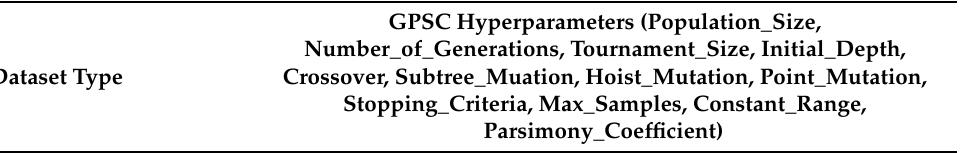
Table 3. The randomly chosen hyperparameters with which the symbolic expressions with highest classification accuracy were